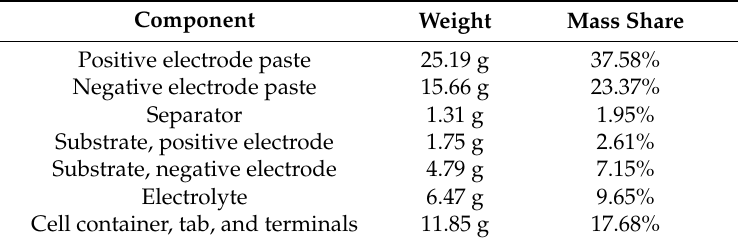
Table 1. Mass repartition of the cell.